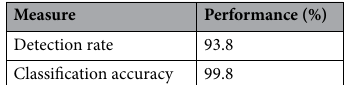
spaced apart on the time axis. High concentration solutions can be easily diluted with the buffer, with the caveat